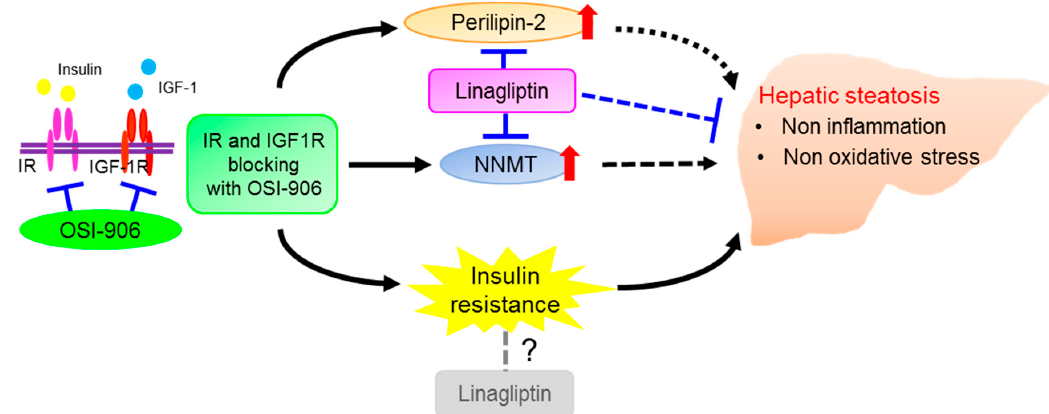
Figure 9. Schematic regulatory pathway of linagliptin in OSI-906-induced hepatic steatosis. Linagliptin improved hepatic steatosis induced by acute IR/IGF1R signaling inhibition with OSI-906 through an insulin signaling-independent pathway. Pathways involving perilipin-2 and NNMT have been proposed as possible mechanisms for the amelioration of OSI-906-induced hepatic steatosis by